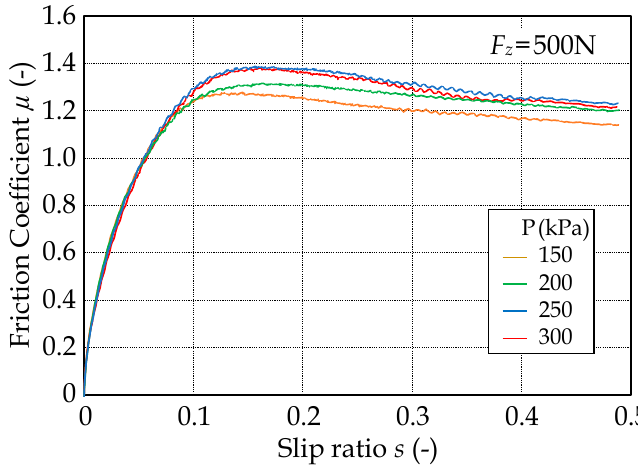
Figure 12. µ -s characteristics against internal pressure Figure 12. μ -s characteristics against internal pressure changes.